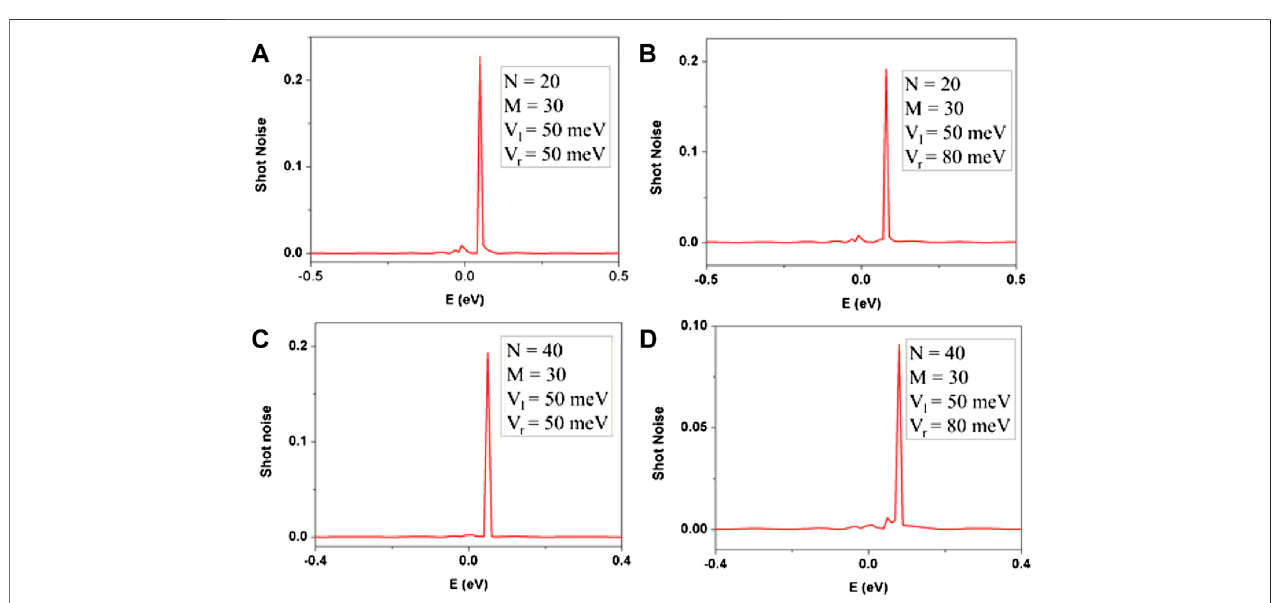
FIGURE 7 | Shot noise power for (A) symmetric potential well with N = 20, (B) asymmetric well with N = 20, (C) symmetric potential well with N = 40, and (D) asymmetric potential well with N = 40.